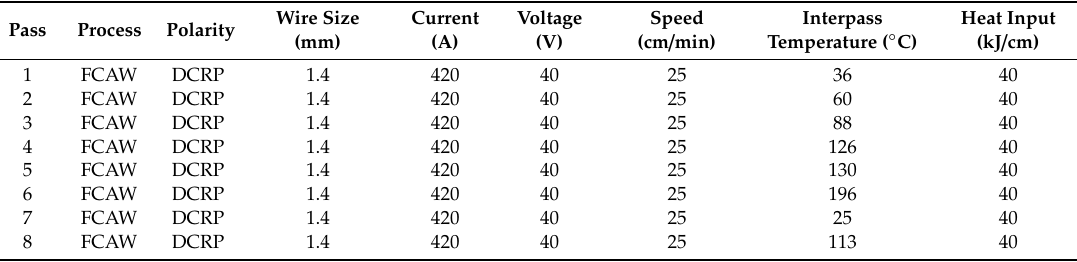
Table 1. Flux-cored arc welding (FCAW) conditions for the 30 mm thick plate.